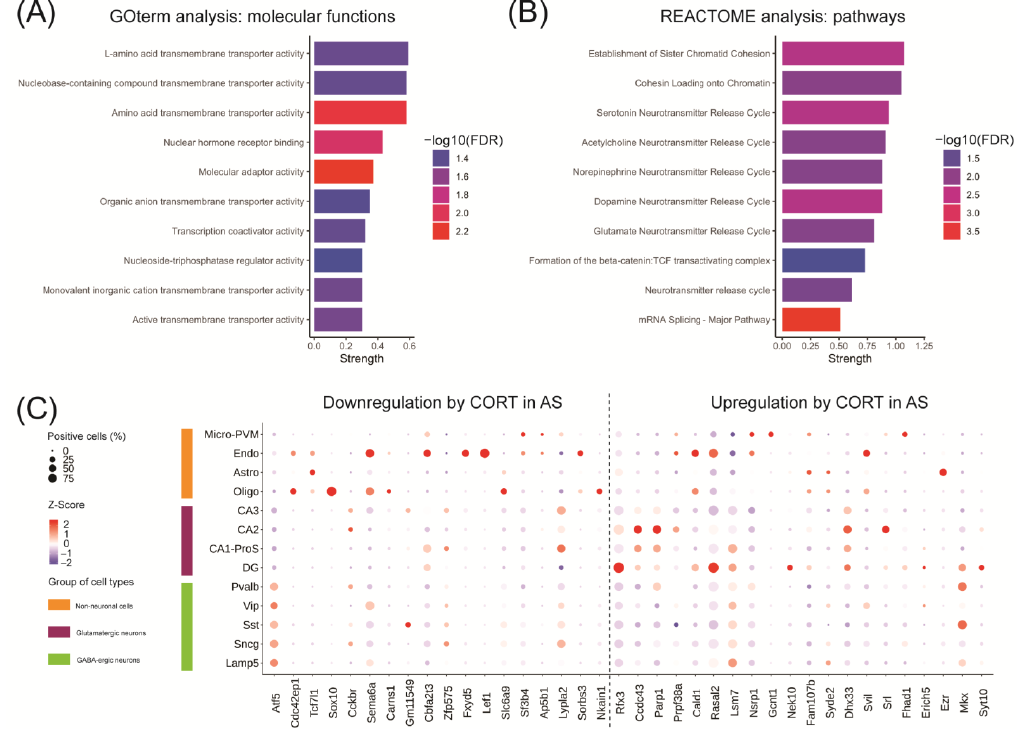
Figure 4. Acute corticosterone exposure in the hippocampus of UBE3A-deficient AS mice influences genes associated with transcription activity and neurotransmitter signaling and are heterogene- ously expressed in hippocampal cell types. ( A , B ) Top 10 terms identified in the ( A ) gene ontology analysis of molecular functions and ( B ) REACTOME pathway enrichment analysis associated with the 1208 genes differentially altered by acute corticosterone treatment in AS mouse hippocampus. The terms were ranked by strength which represents the log10-transformed ratio between the genes annotated with the term to the number of genes expected to be annotated with this term in a random network of comparable size. Enrichment significance is expressed as the — log10(FDR). ( C ) Top 40 genes differentially altered by acute corticosterone treatment in AS mouse hippocampus expression throughout mouse hippocampal cell types. The size of the dots represents the percentage of cells positive for the gene of interest while the colored Z-Score represents the normalized average expres- sion of the gene of interest within one cell type. Cell types were categorized as: non-neuronal cells, glutamatergic neurons, and GABA-ergic neurons. Glutamatergic neurons were separated based on hippocampal sub-regions: the dentate gyrus (DG) and the cornus ammoni regions (CA1-ProS, CA2 and CA3). Genes were divided according to their direction of regulation after acute corticosterone (CORT) treatment in AS. 2.5. Acute CORT Exposure Influences Genes in the UBE3A-Deficient AS Mouse Hippocampus That are Heterogeneously Expressed in Hippocampal Cell Types We selected the top 40 genes from the 1,208 genes which significantly contributed to the genotype-treatment interaction and characterized their cell type-specific expression using our adult mouse hippocampus atlas (Figure 4C). Two genes from the selected subset were undetectable in the hippocampus cell atlas: Mir5125 which was not captured by 10× scRNA-seq, and Adnp . The expression of genes appeared heterogenous throughout dif- ferent hippocampal cell types, e.g., Rfx3 and Rasal2 were highly expressed in the